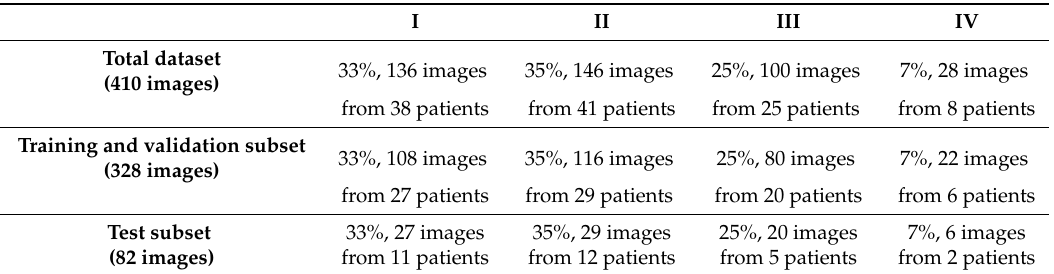
Table 1. Distribution of densities across imbalanced INbreast dataset (before